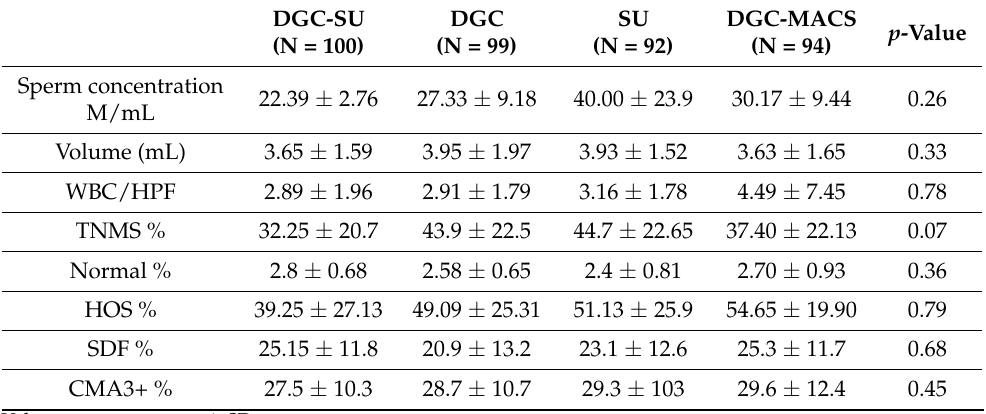
Table 2. Sperm concentration, volume, WBC/HPG, TNMS (total normal motile sperms), normal % (normal morphology), HOS % (hypo-osmotic swelling), SDF% (sperm DNA fragmentation) and CMA3% levels in the whole studied